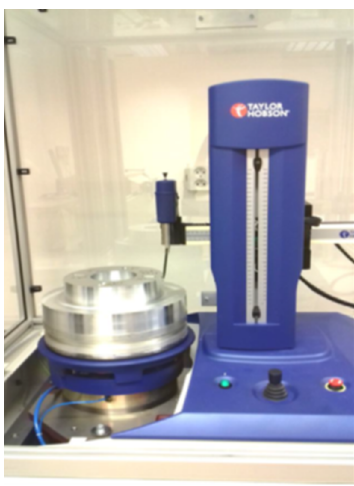
Figure 4. Talyrond 595S, workpiece measurement. Table 7. Talyrond 595S specifications [32].